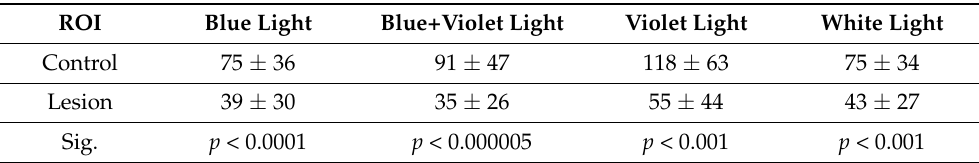
Table 7. Microcontrast analysis in lichen planus images in oral mucosa. Four ways of lesion illumination in pre-treatment